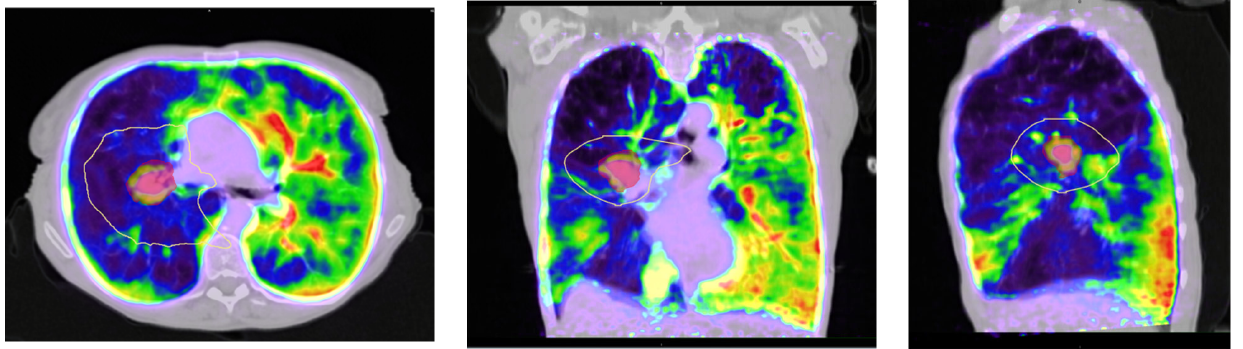
Figure 2. Axial ( left ), coronal ( middle ), and sagittal ( right ) slices of registration between lung perfusion PET/CT using Gallium ‐ 68 ‐ MAA (in red: the most functional areas; in blue: the least functional areas) and treatment planning computed tomography simulation scan. The planning target volume (PTV) is contoured in red; the V26Gy is the yellow line.